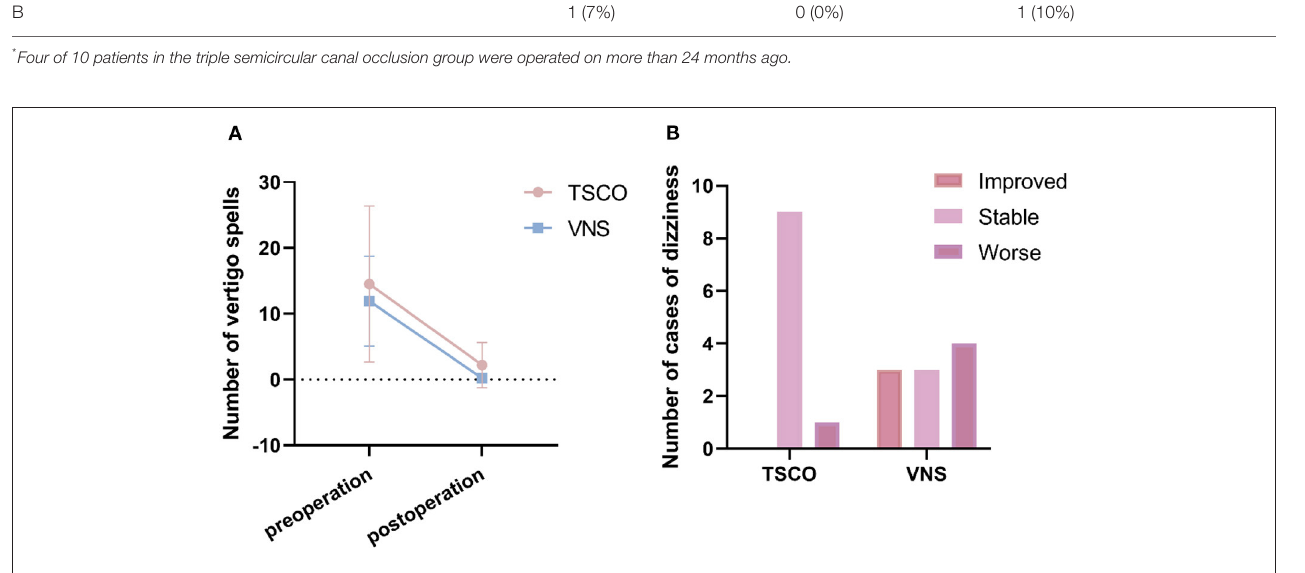
FIGURE 2 | Incidence of postoperative vertigo and paroxysmal dizziness. (A) Vertigo spells were controlled by both triple semicircular canal occlusion (TSCO) and vestibular nerve resection (VNS), and there was no significant difference in incidence between the two groups. (B) Bar chart comparing the numbers of postoperative cases of paroxysmal dizziness between the two